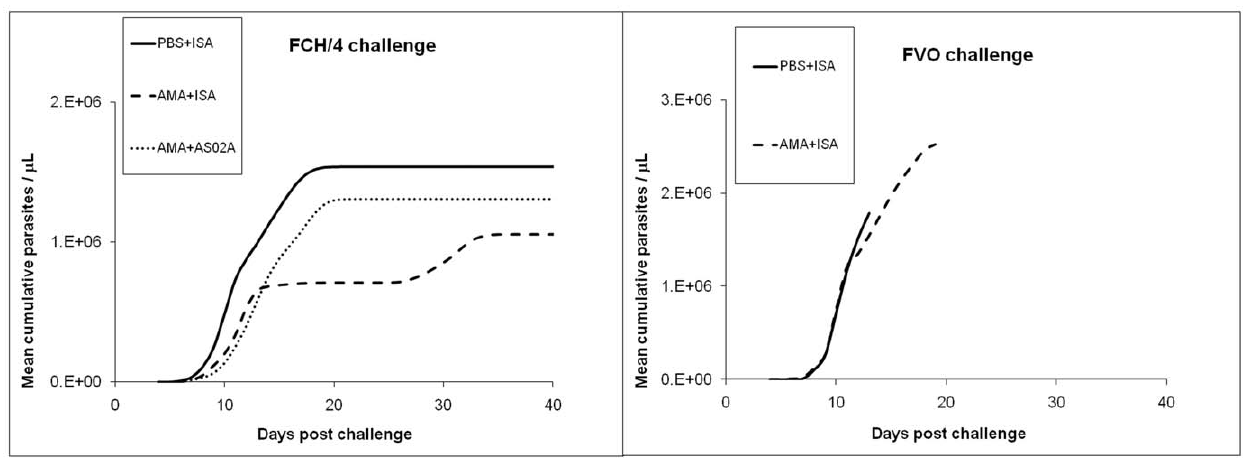
Figure 6. 3D7 AMA1 vaccination slowed growth rate of FCH/4 but not FVO strain. Group-wise mean cumulative parasitemia of the FCH/4 (left panel) and FVO (right) challenged animals plotted against days post challenge. Solid line, PBS control group; broken line, AMA + ISA; dotted line,